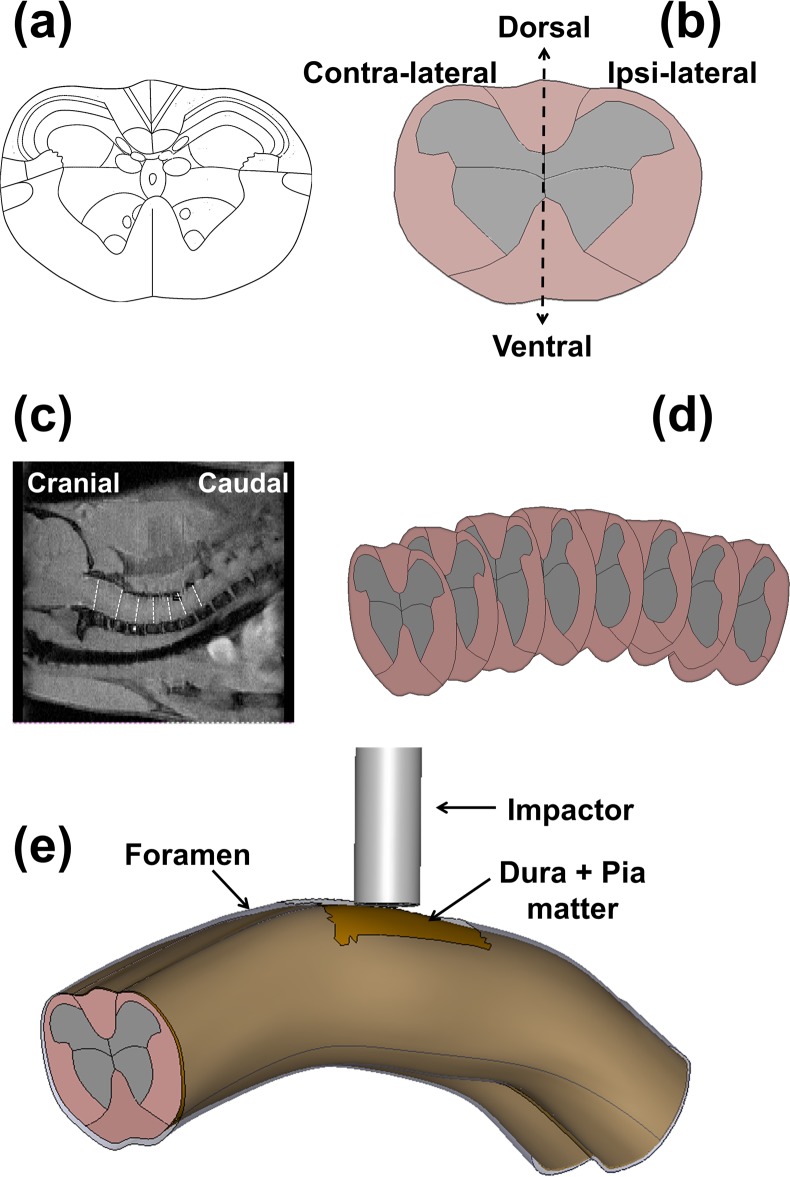
Mouse spinal cord finite element model geometry.(a) Structural map of the spinal cord at the C1 vertebral level (adapted from the Mouse Spinal Cord Atlas [29]); (b) Reconstruction of the slice with delimitation of 8 regions of interest: dorsal, ventral, ipsilateral and contralateral white matter and ipsi-dorsal, ipsi-ventral, contra-dorsal and contra-ventral gray matter; (c) MRI acquisition [30] of the spinal cord in the sagittal plane allowing position and orientation assessment for each slice at each vertebral level; (d) Inverse MRI-based curvature model of the cervical spinal cord from C1 to C8; (e) 3D model of the SC with meninges, vertebral foramen canal and impactor.